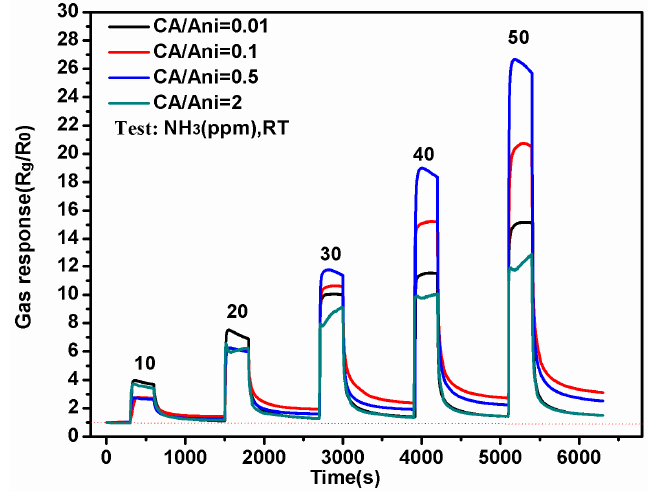
Figure 7. Gas sensing response of the sensors deposited with PANI nanomaterials with different morphologies to ammonia ranging from 10 to 50 ppm at room temperature.